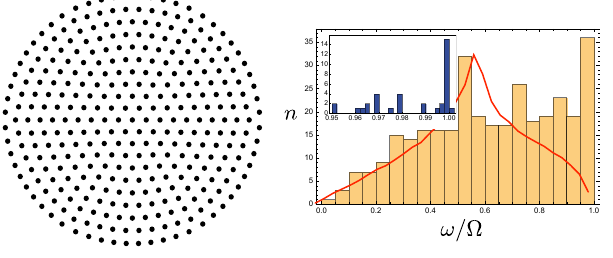
Figure 2: Left: equilibrium configuration for s = 10, N = 331 vortices. For ω = 1, radius is equal to 17.44. The vortices form a distorted hexagonal lattice, note the outer circle is rotated by half a lattice consistent with Campbell and Ziff [ 10, 11 ] . Right: numerically calculated density of states for N = 331 (total of 331 vortices). Red line shows the continuum limit, note the absence of a frequencies near ω/ Ω = 1 in this case. Inset: cluster of frequencies close to ω/ Ω = 1, corresponding to anti- holomorphic